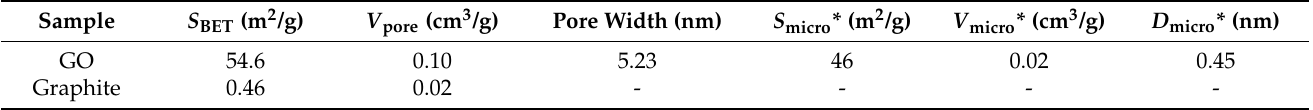
Table 1. Textural characteristics of the carbon materials.